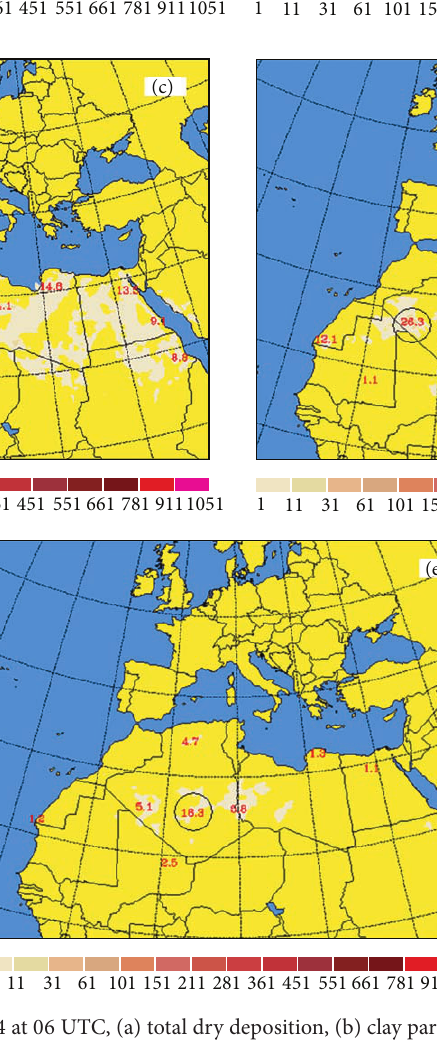
Figure 4: Dry deposition on 3 March 2004 at 06 UTC, (a) total dry deposition, (b) clay particle, (c) small silt particle, (d) large silt particle, and (e) sand particle. The black circle indicates the maxima of dry